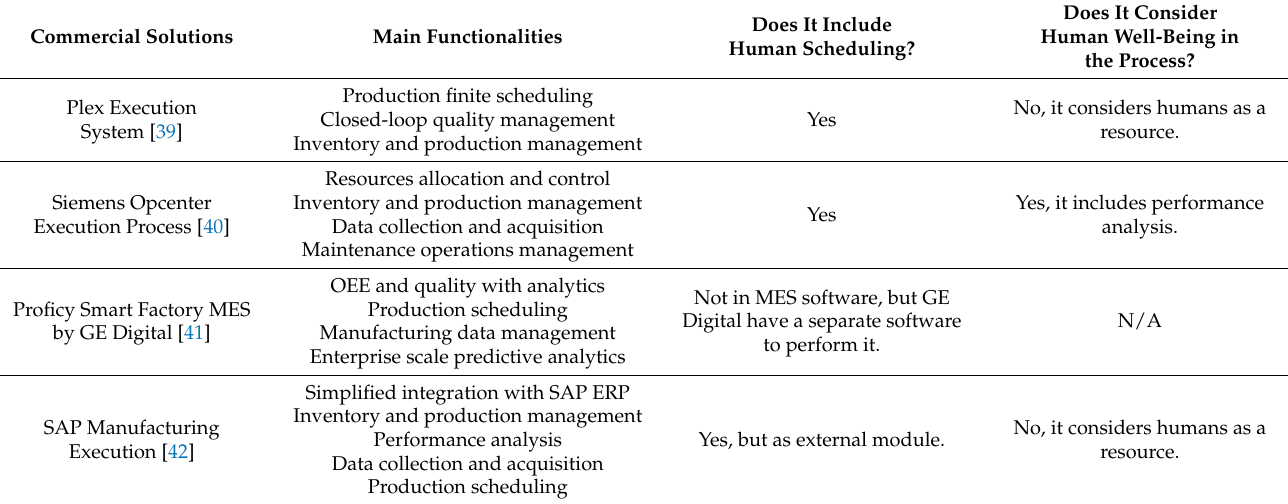
Table 1. Commercial solutions in MES providers.